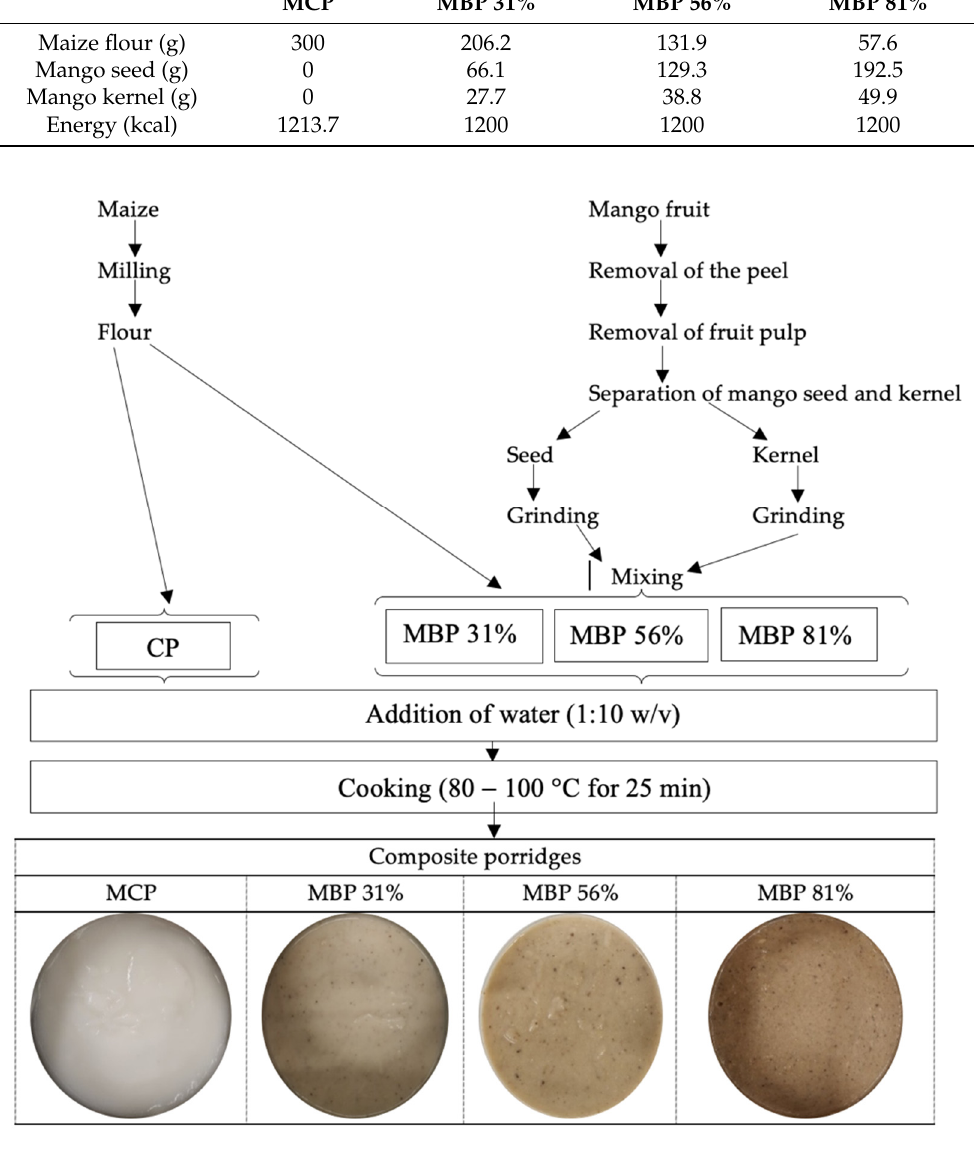
Figure 1. Flowchart showing the preparation of maize composite porridges (wt).